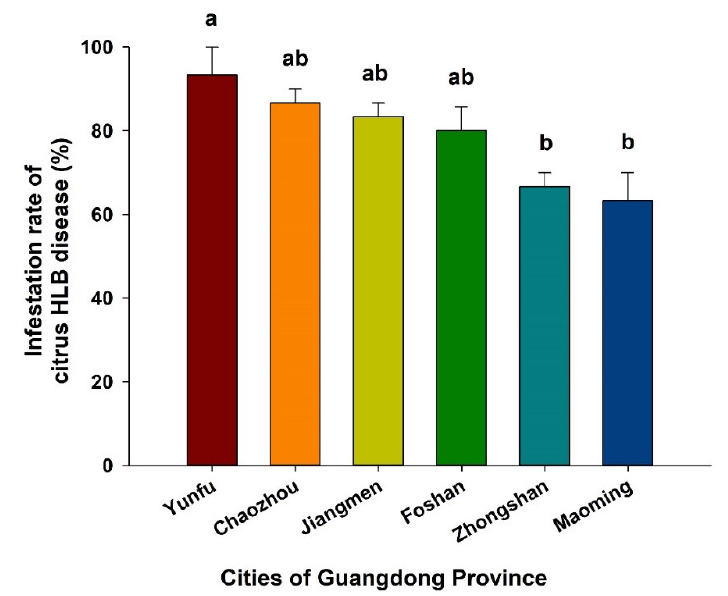
Figure 2. Percentage of D. citri adults infected with C Las in different areas of Guangdong province. The bars display the average infection rate from three replications. The standard deviation of the mean is shown by the standard error bars. The significance of the treatments at p < 0.05 is shown in lowercase lettering. Similar letters represent no significant difference.